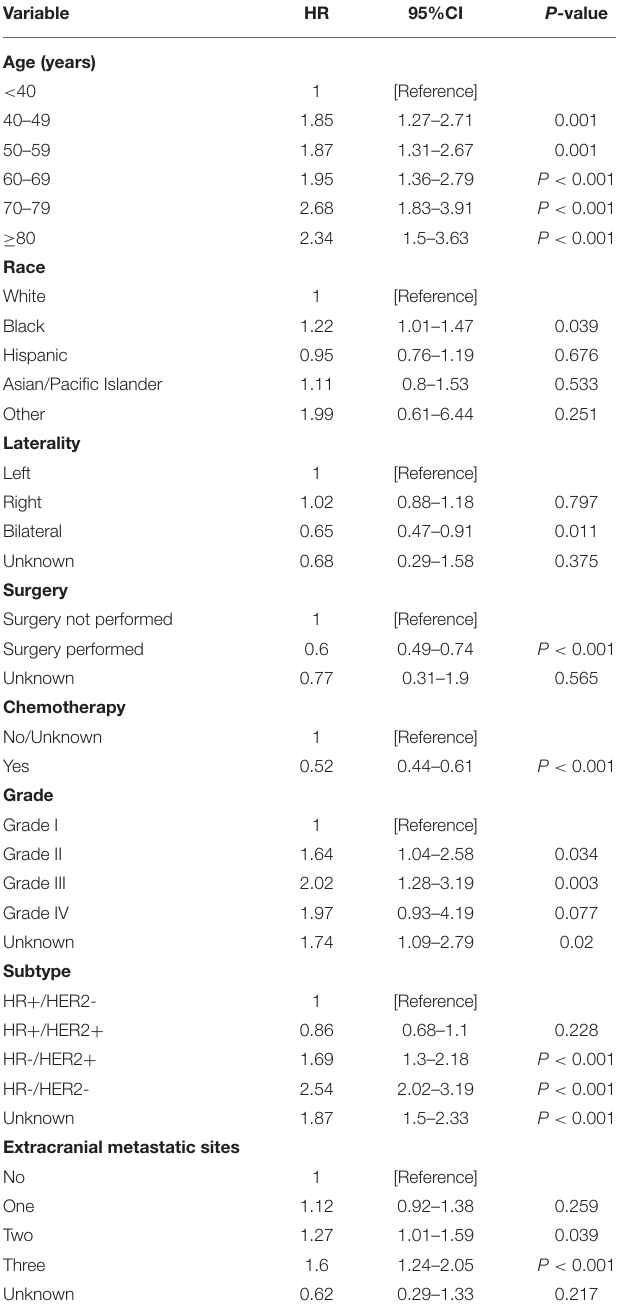
TABLE 2 | Multivariate analysis of the training